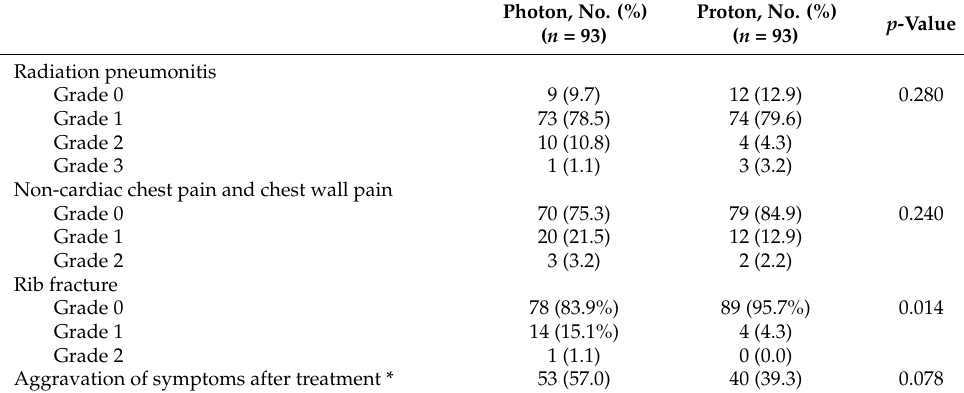
Table 3. Treatment-related adverse